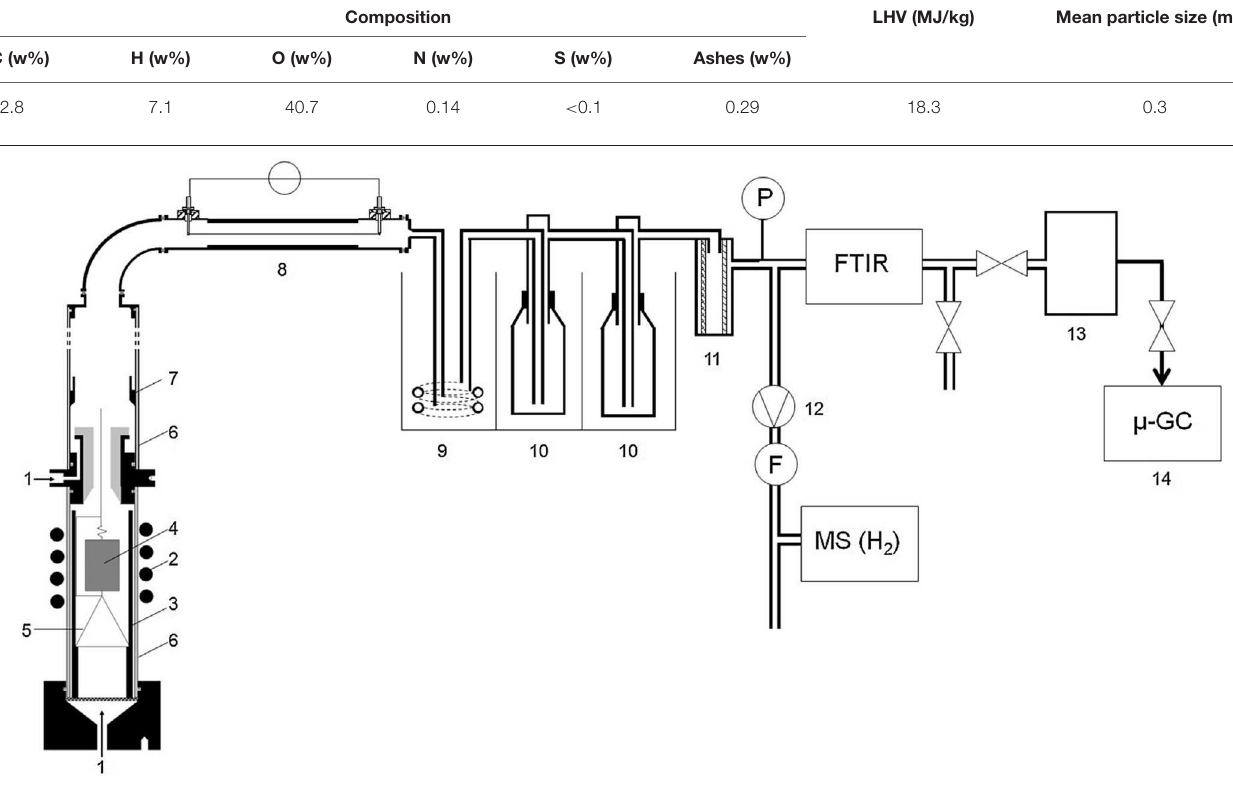
FIGURE 5 | Experimental bench PYRATES : (1) Gas inlet (N 2 on top, N 2 , CO 2 and H 2 O on bottom); (2) Inductor; (3) Inconel pipe; (4) Wood sample; (5) Metallic sample holder; (6) Quartz pipe; (7) Tar collector; (8) Electrostatic precipitator; (9) Ice trap (0 ◦ C); (10) Dry ice trap ( − 70 ◦ C); (11) Cartridge filter; (12) Pump; (13) Tedlar bag; (14) Micro-Gas chromatograph; (FTIR) Fourier Transform InfraRed Spectroscope; (MS) Mass spectroscope ( Gauthier et al., 2013).